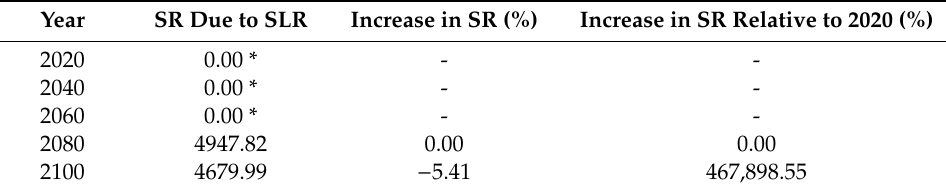
Table 5. Social Risks (SR) at Fethiye due to Sea Level Rise (SLR).